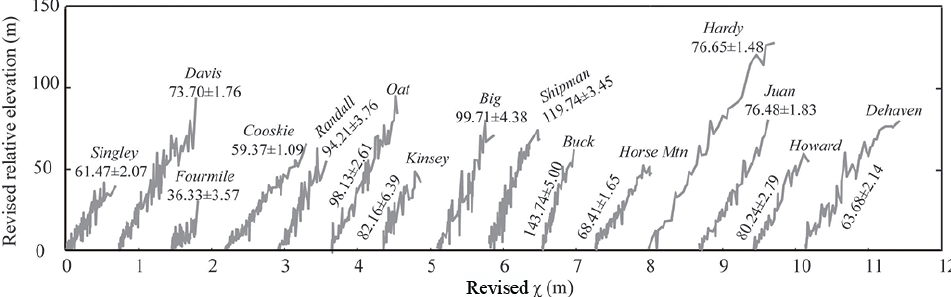
Figure 8. Revised relative elevation and χ values. Gray lines and numbers are revised data and steepness index with uncertainty estimates.